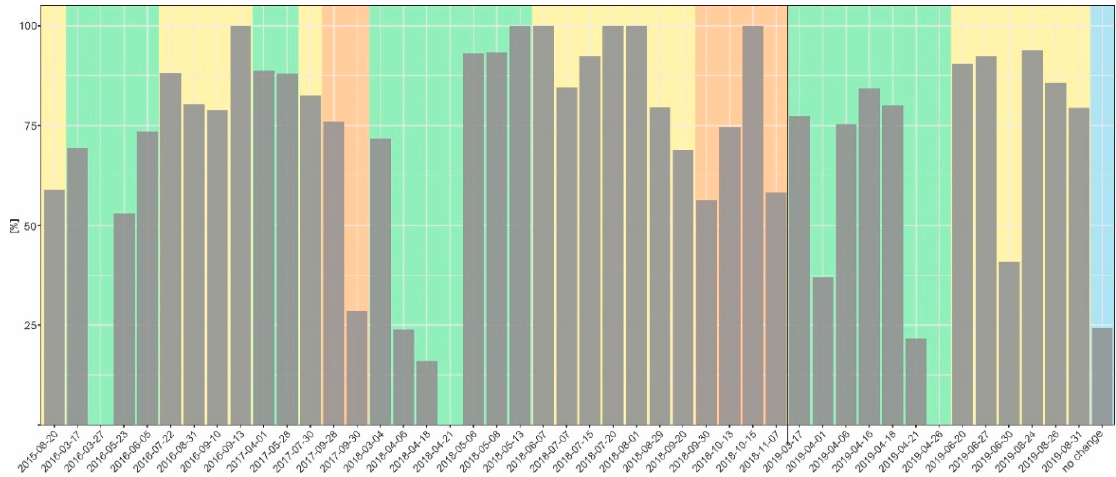
Figure 8. Macro-averaged F1 score for the best detection map (SWIR1). Spring months highlighted in green, summer—yellow, autumn—orange.